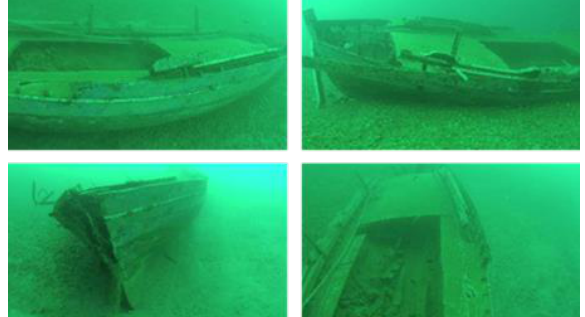
Figure 5. Sample of data set of shipwreck